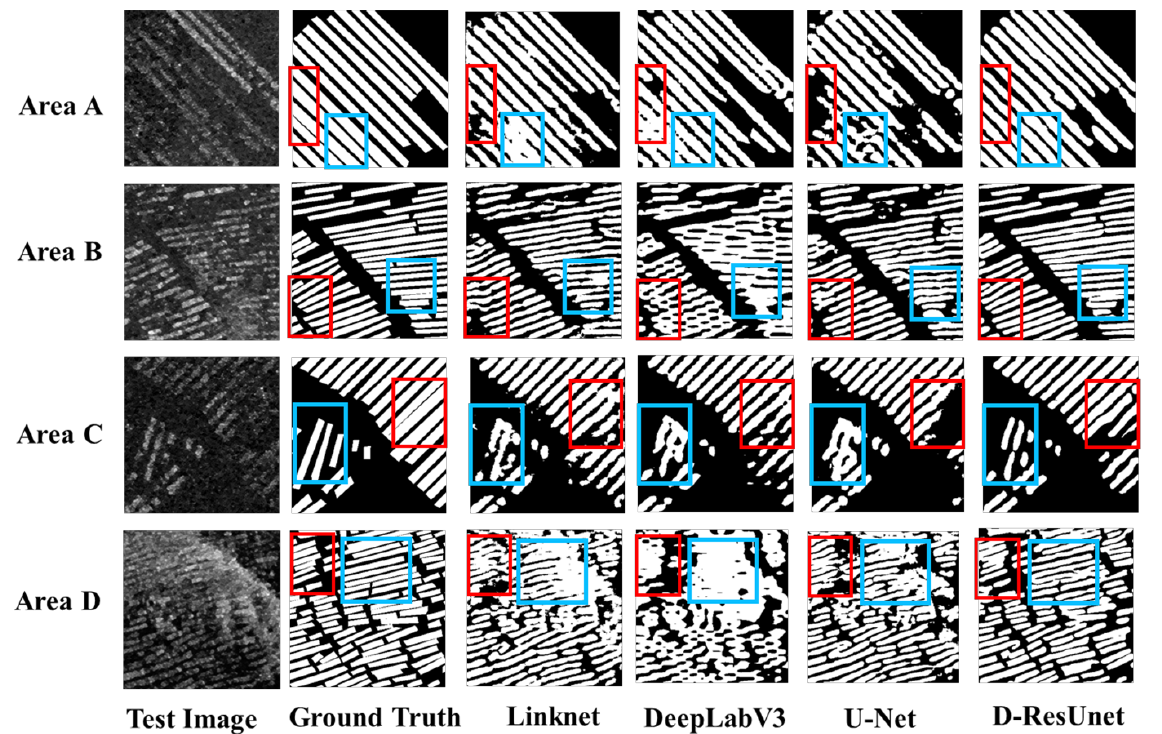
Figure 6. Resulting maps of four models in four randomly selected test areas. Black pixels represent the ocean background and white pixels represent the extracted FRA areas. Red rectangles are areas where the FRA area is easily missed, and blue rectangles are areas where the FRA extraction result is prone to adhesions.